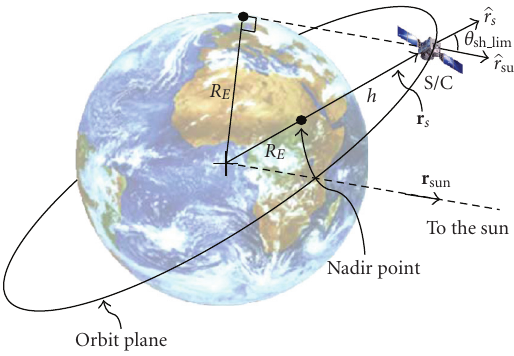
Figure 7: Shadow angle geometrical